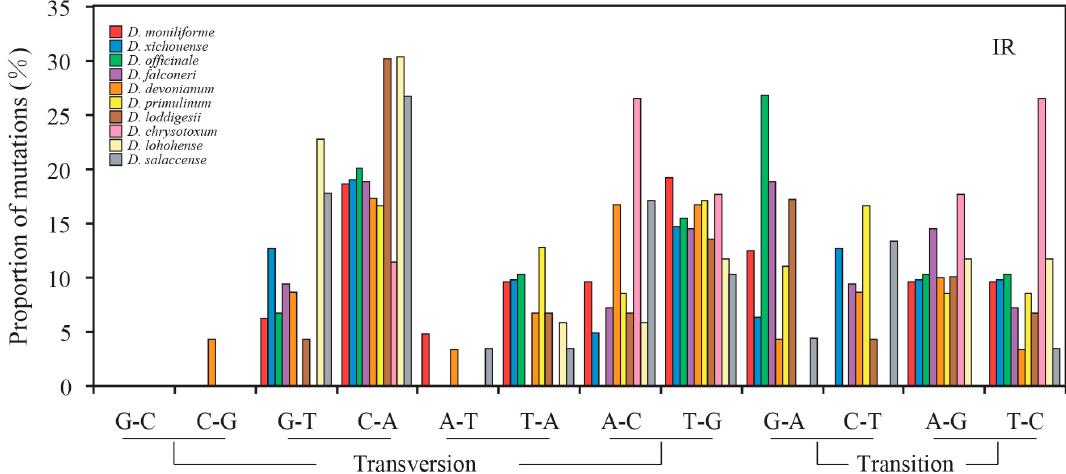
Figure 4. Proportion of the six nucleotide-pair mutations estimated from non-coding loci of the SC and IR regions of 10 Dendrobium species. The numbers of A to G mutations are normalized for the unequal nucleotide content of Dendrobium species. The frequencies of transversions are higher than that of transitions in both SC and IR regions.